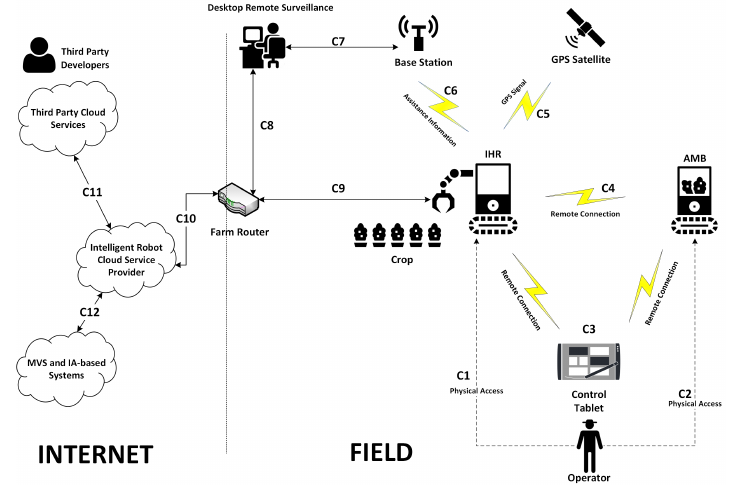
Figure 1. The intelligent harvesting robot system and its key